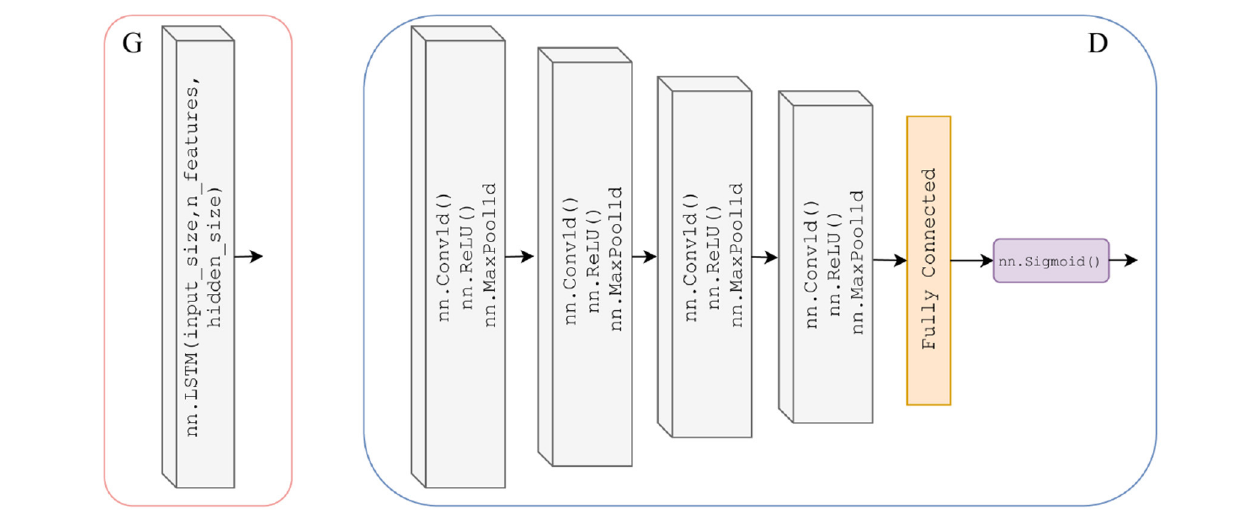
FIGURE 4 | Detailed architecture of generator (left) which is a two-layer stacked LSTM with 50 hidden units in each layer and a fully connected layer at the output, with an input size varied to match the segment length for the chosen dataset. Architecture of discriminator (right) which is a 4-layer 1-dimensional CNN (ReLU activation and max pooling functions) with a fully connected layer and sigmoid activation function at the